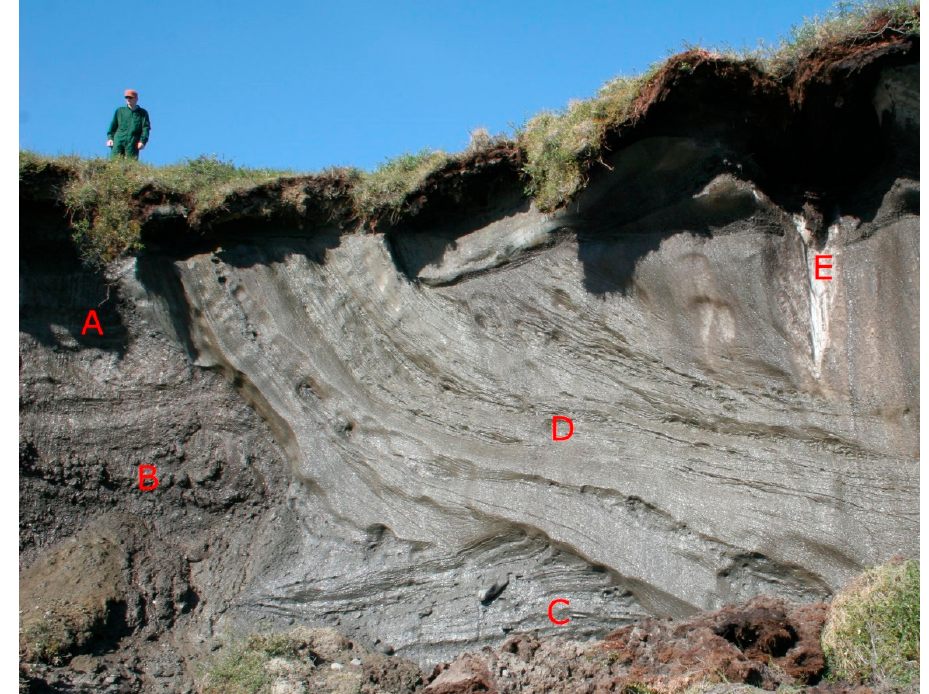
Figure 5. Exposure of ground ice from slump NOAT039. A—frozen loess, B—frozen glacial till, C—Pleistocene glacial ice (note the cobbles), D—Pleistocene ice wedge, E—Holocene ice wedge.